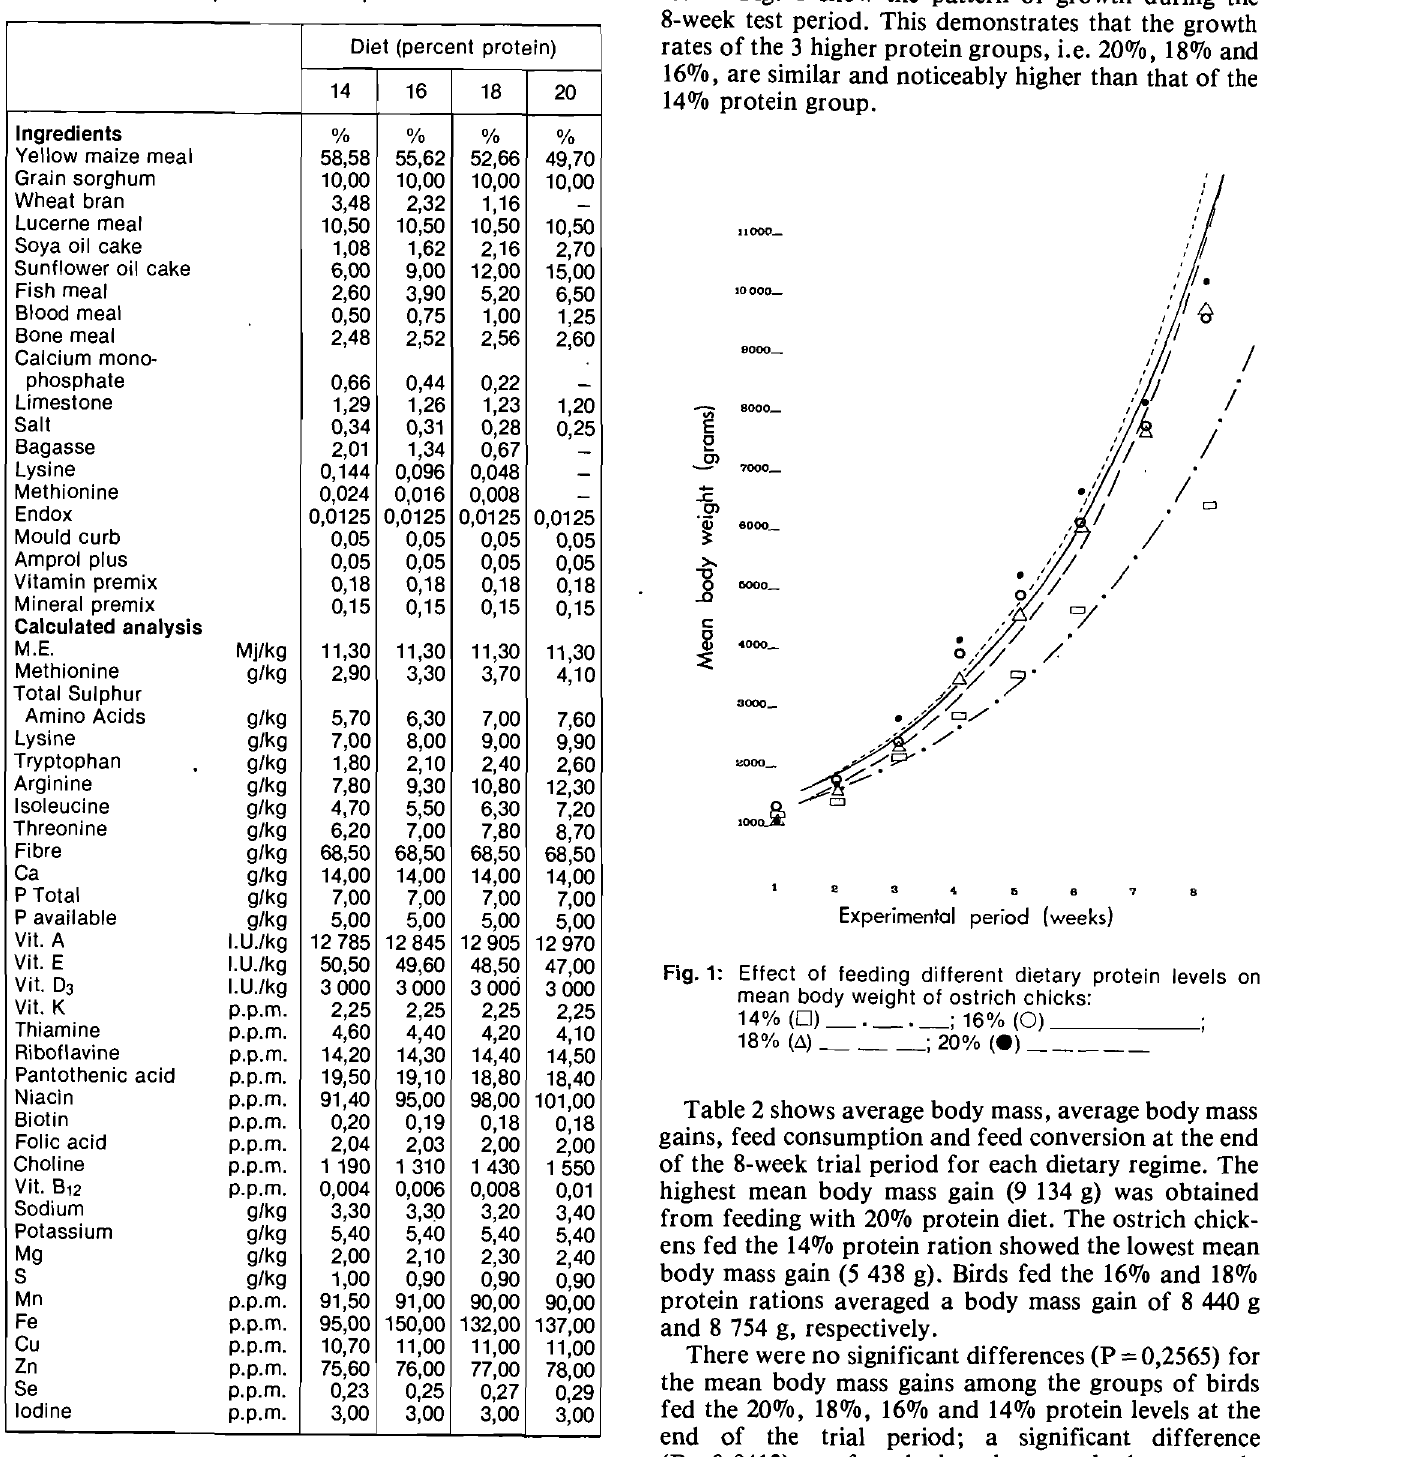
Table 1. Composition of experimental diets Diet (percent protein)